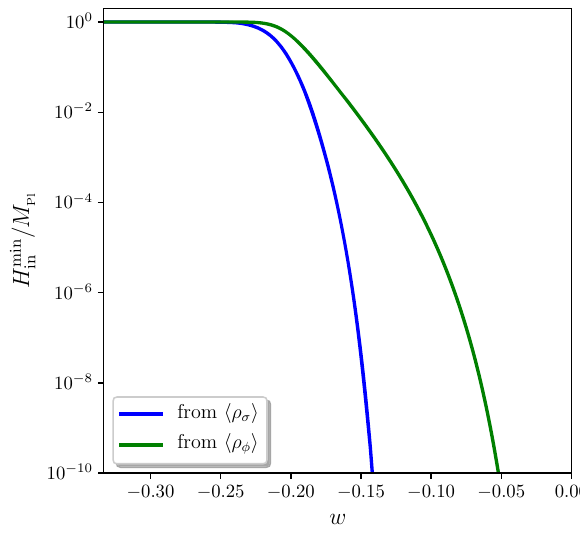
Fig. 2 Minimum value of the initial Hubble parameter (parametrising themaximumamountofcontraction)suchthatthebackreactioncoming from the shear (blue curve) and from the spectator field fluctuations (green) remain negligible until the time when the overall energy density reaches the Planck